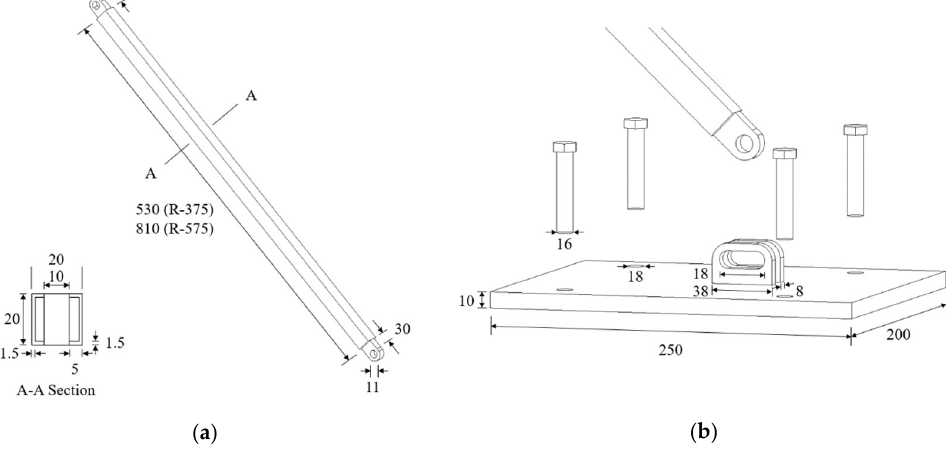
Figure 3. Dimensions of the RSL system (mm): ( a ) Steel link; ( b ) Bo tt om plate.